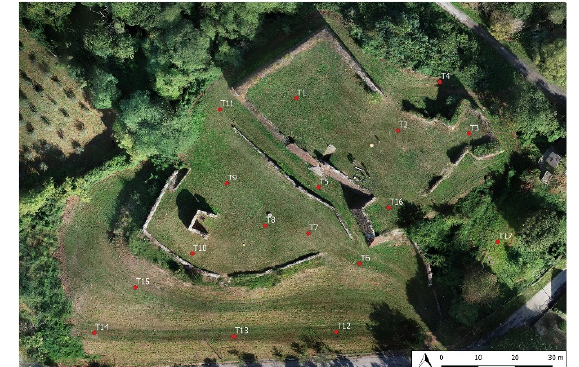
Figure 1 (a) Distribution of the control points measured on the test site (red